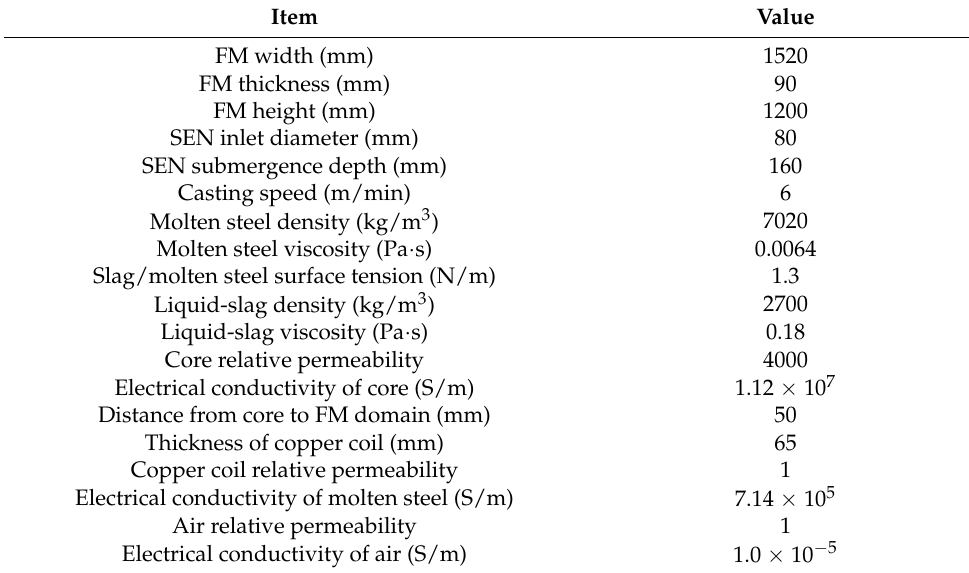
Table 1. Parameters used in numerical simulations [40,41].